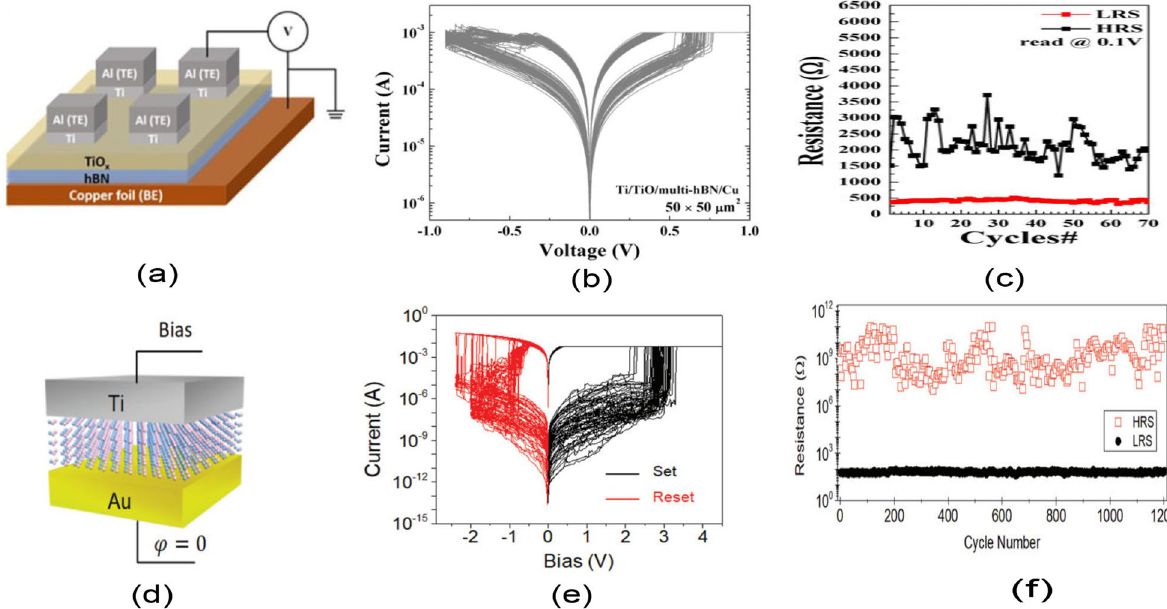
Fig. 23 Hexagonal boron nitride 2D-based material used in RRAM devices. a , b and c Sketch, I–V curves and DC endurance cycles of Al/Ti/ TiOx/multilayer hBN/Cu device [270]. d , e and f Schematic, I–V characteristics and endurance cycles of the Ti/hBN/Au device obtained at the bias of 0.05 V, respectively